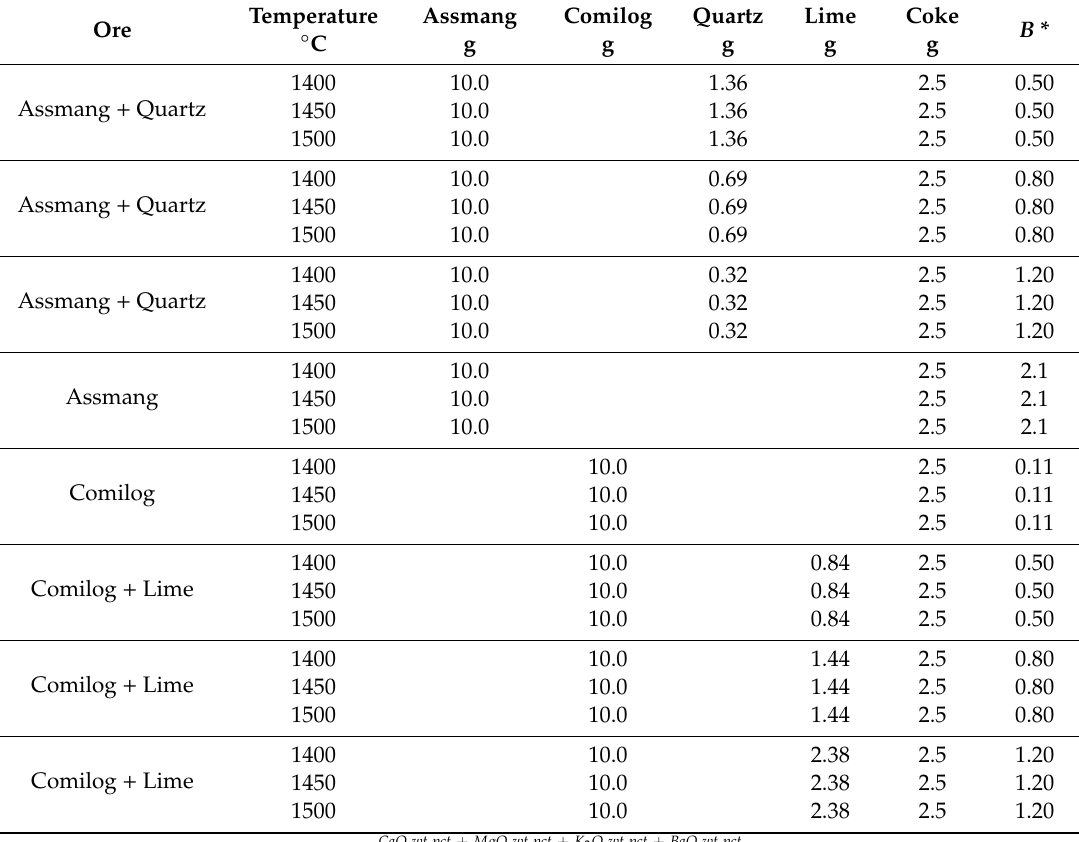
Table 2. Experimental